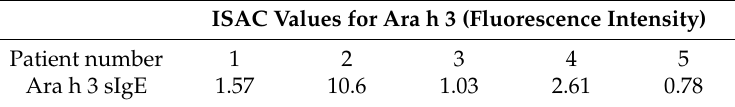
Table 1. Specific IgE levels against Ara h 3 determined by ISAC